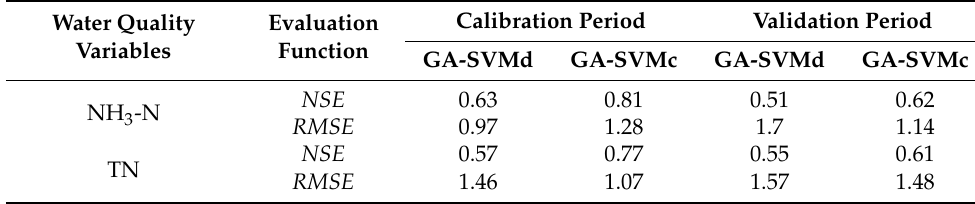
Table 4. The modeled accuracy results in the calibration period and the validation